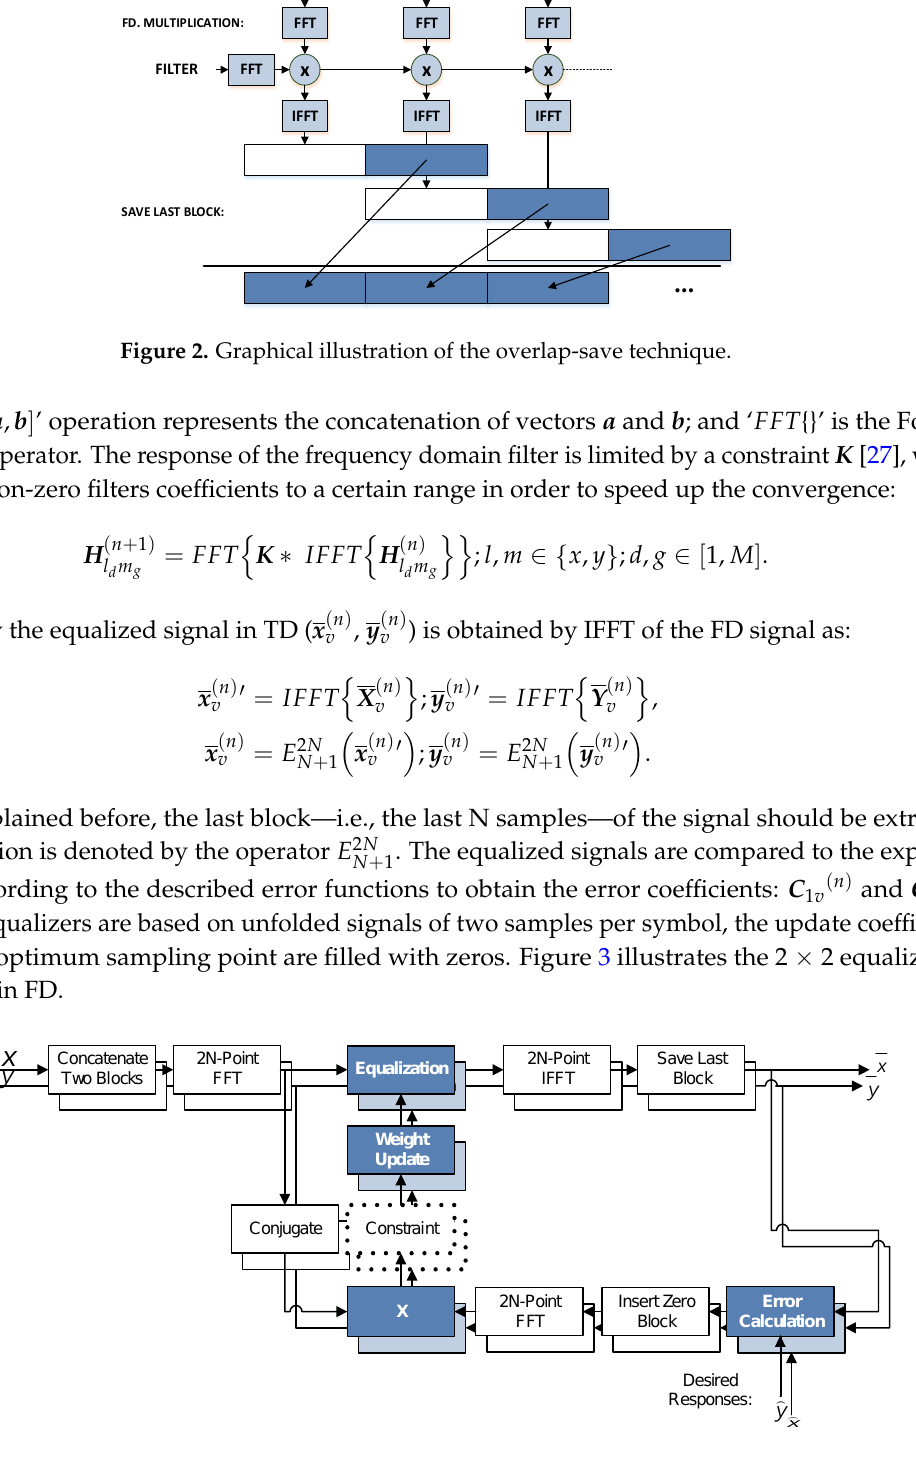
Figure 3. 2 × 2 frequency domain (FD) equalizer by showing the most relevant steps.